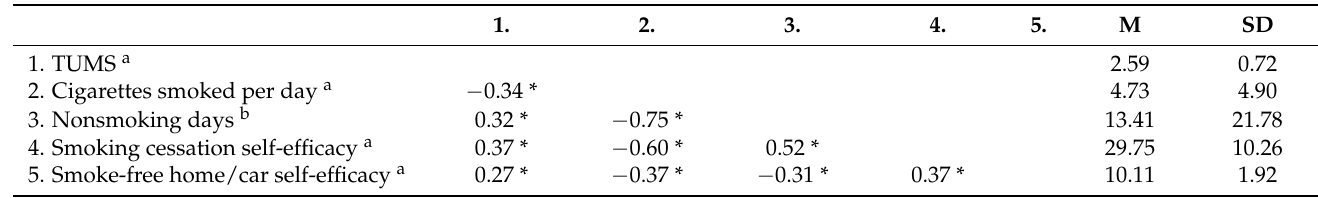
Table 3. Descriptive and correlational data on major variables (n =